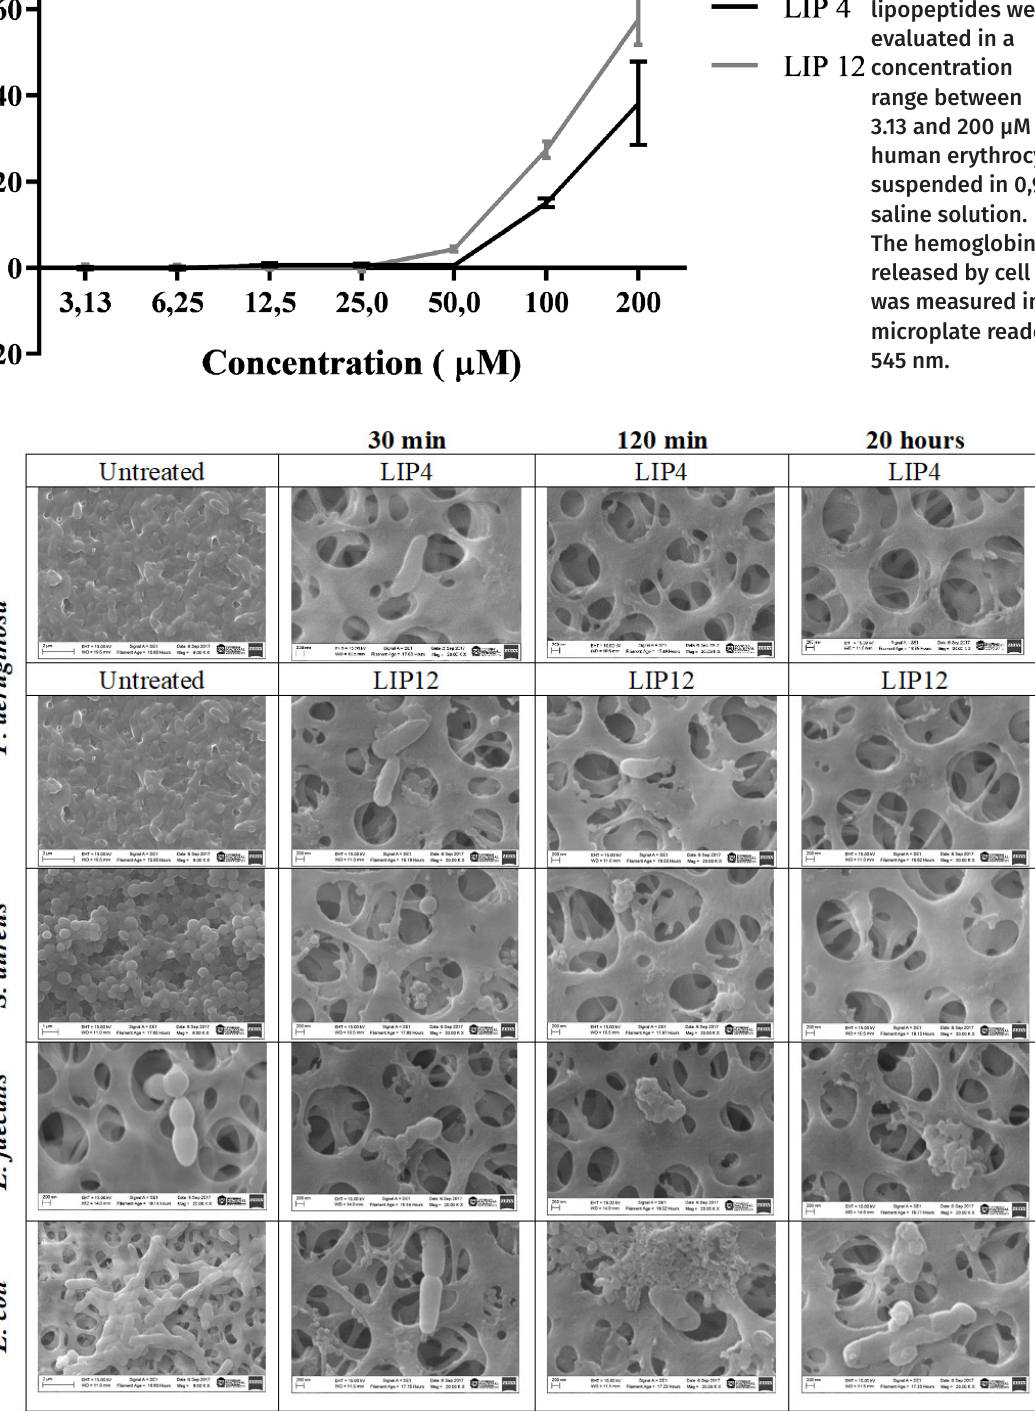
Figure 4. Scanning electron micrographs of E. coli , E. faecalis , S. aureus and P. aeruginosa cells untreated and treated with LIP 4 and LIP12 for 30 minutes, 120 minutes and 2 hours at 2 times their